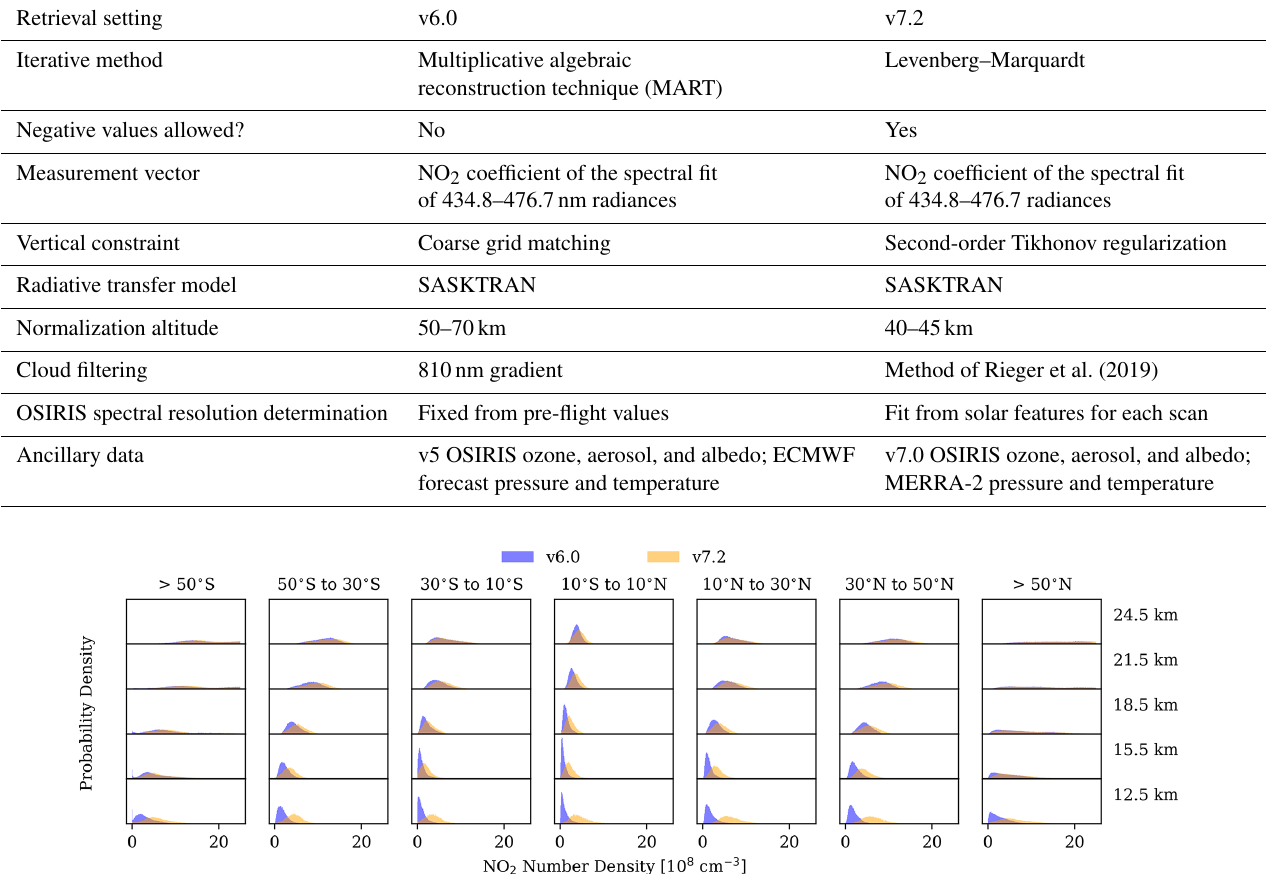
Table 2. Settings for the OSIRIS v6.0 and v7.2 NO 2 retrievals.